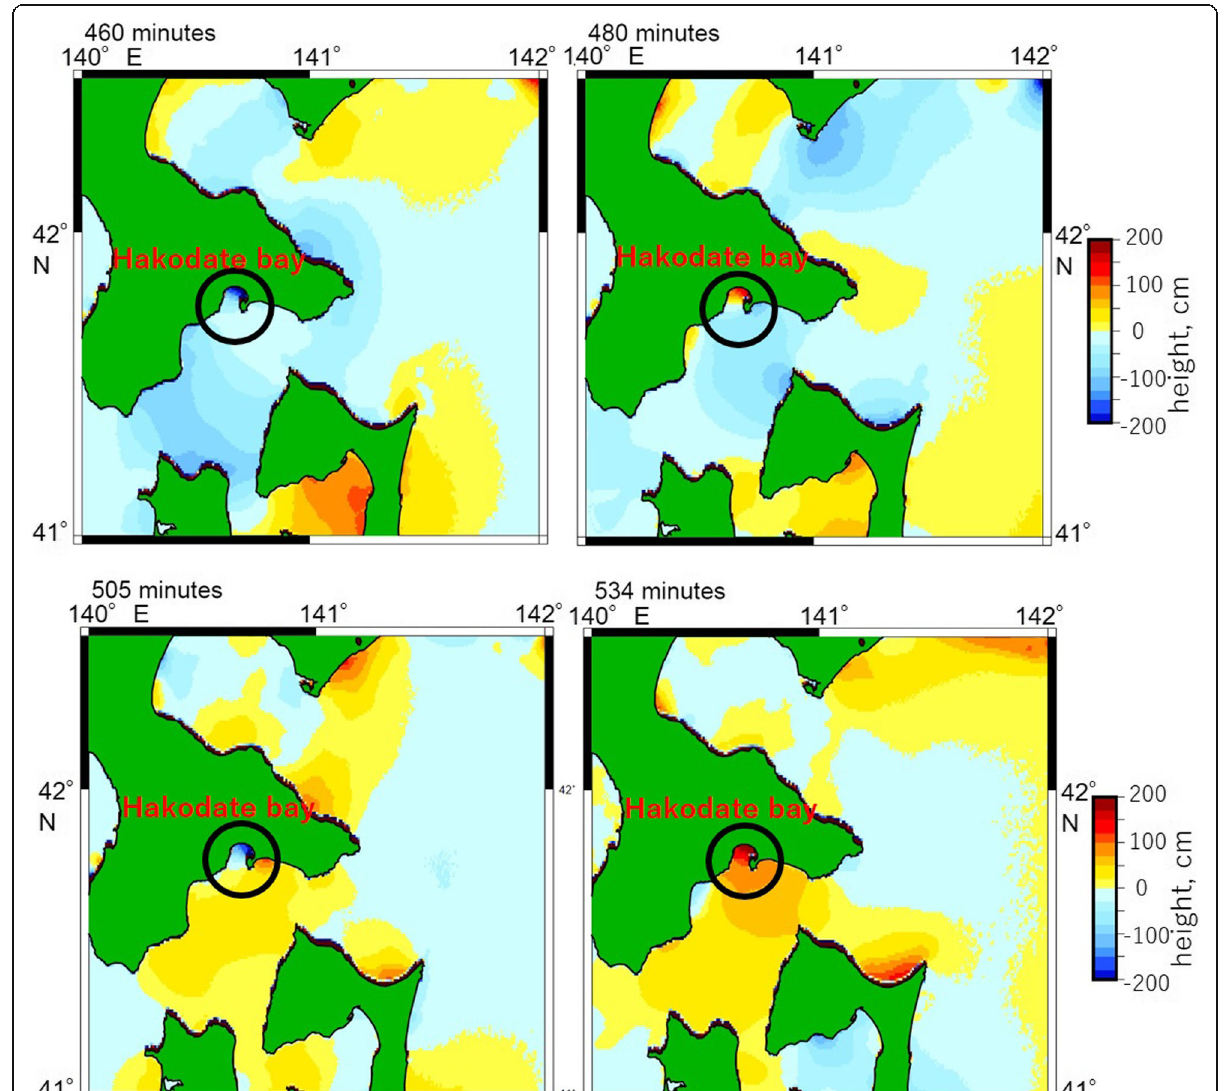
Fig. 4 Snapshots of the tsunami height distribution around Hakodate taken 460, 480, 505, and 535 min after the earthquake, as